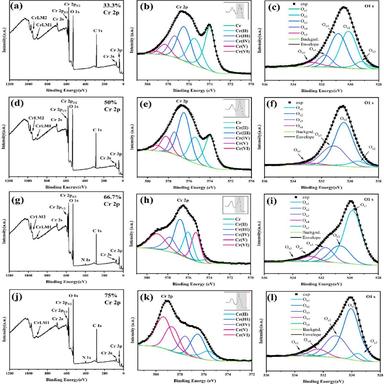
XPS spectra of chromium oxide films at varying oxygen partial pressures. Fig. (a)–(c) at 33.3 %, (d)–(f) at 50 %, (g)–(i) at 66.7 %, and (j)–(l) at 75 %. Each set includes total spectrum, Cr 2p, and O 1s core level diagrams.